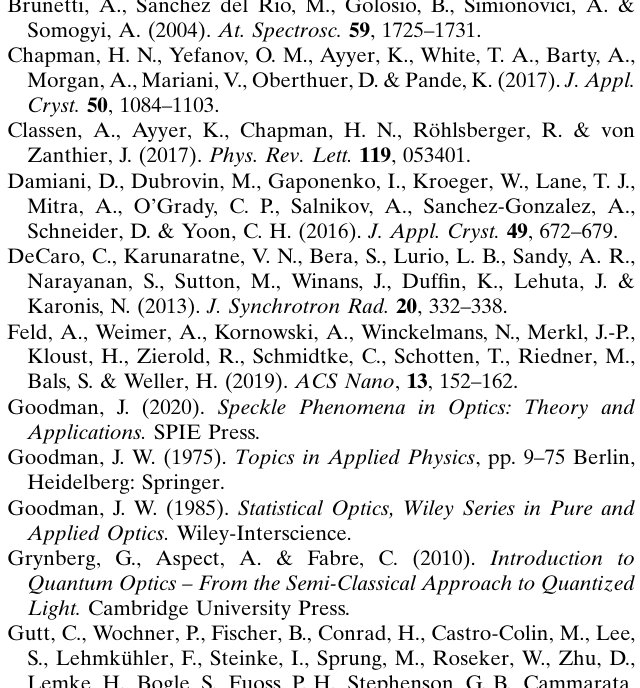
Figure 8 Illustration of the LAP photonization